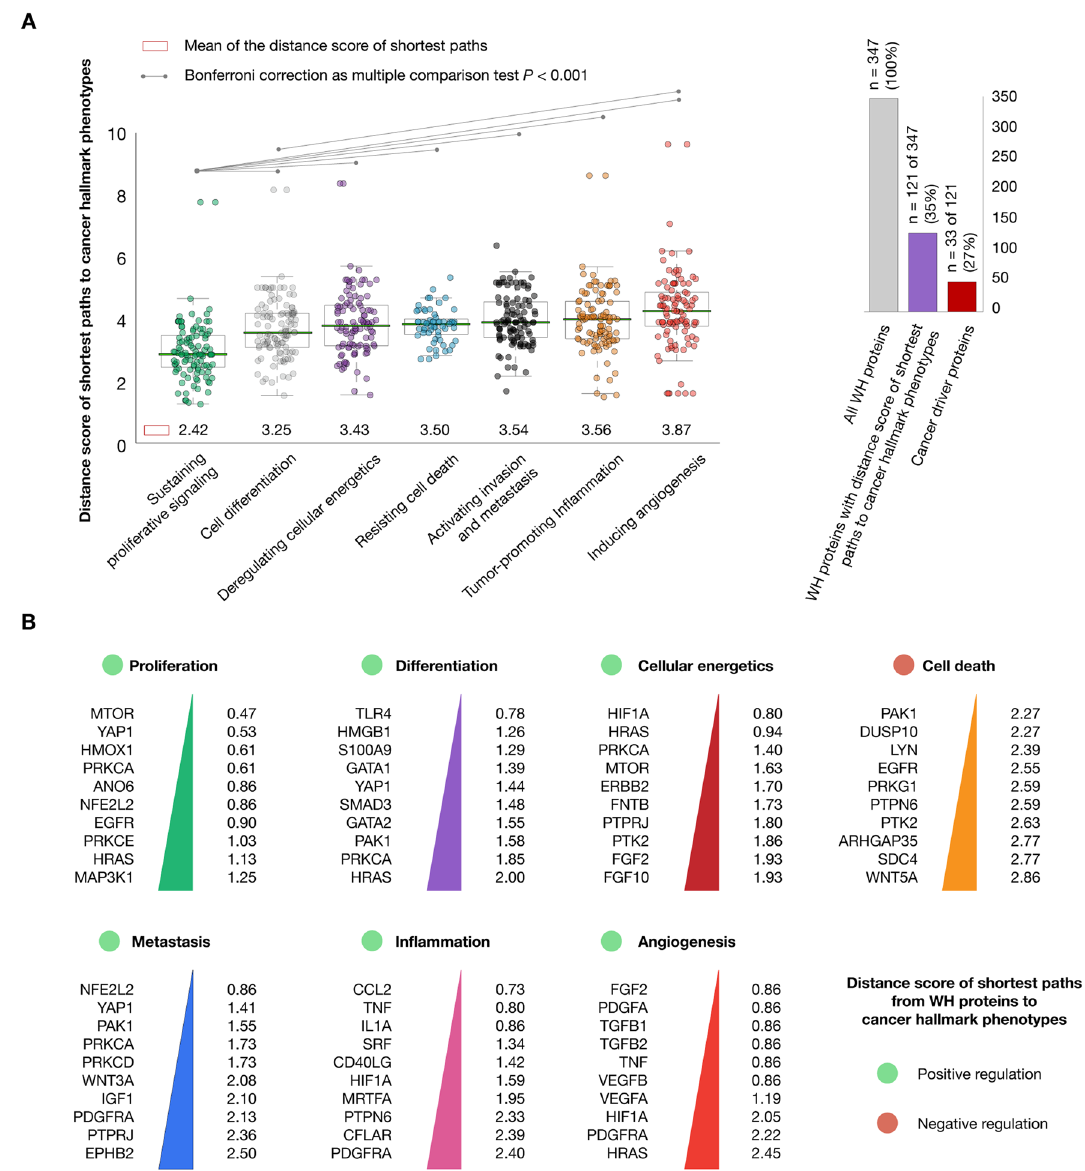
Figure 5. Shortest paths to cancer hallmark phenotypes. ( A ) Mean of the distance scores of shortest paths from wound healing proteins to cancer hallmark phenotypes and Bonferroni correction as multiple comparison test ( P < 0.001). ( B ) Top ten wound healing proteins with the shortest distance scores of positive regulation to proliferation, differentiation, cellular energetics, metastasis, inflammation and angiogenesis, and negative regulation to resisting cell death. Lastly, the shortest paths to cancer hallmark phenotypes were analyzed by using data from CancerGenNet (https:// signor. uniro ma2. it/ Cance rGene Net/) 35